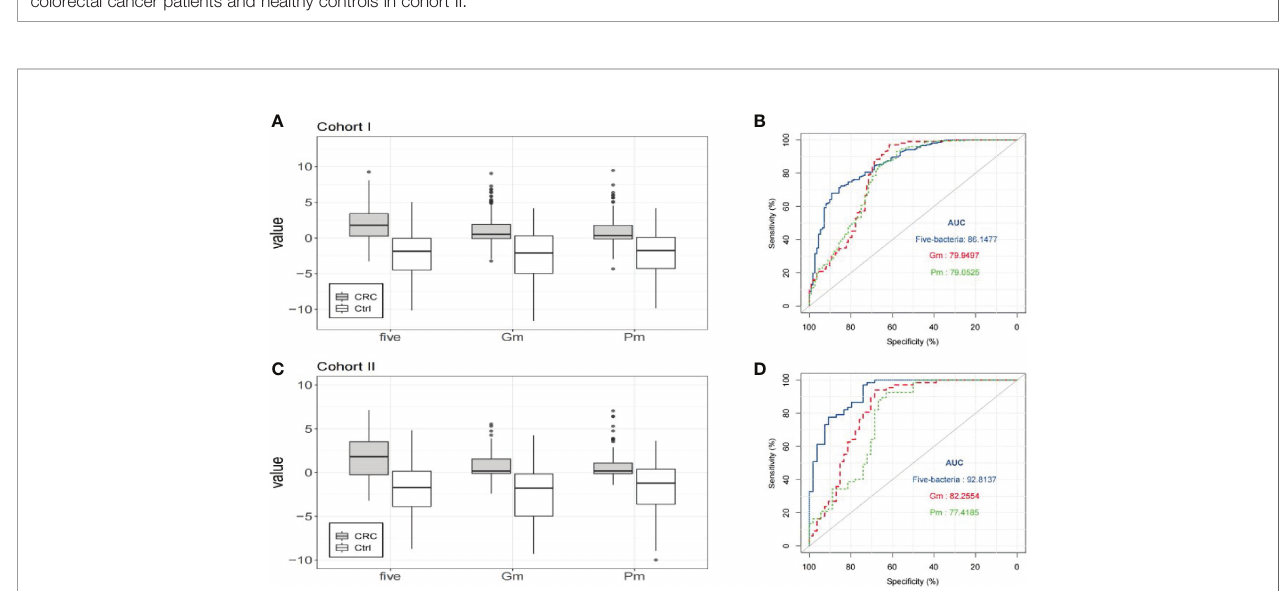
FIGURE 3 | The combination of fi ve markers can improve the diagnostic ability of colorectal cancer (CRC). (A) Compared with the healthy control group of cohort I, the relative stool abundance of Gm , Pm , and fi ve bacteria ( Gm , Pm , Pc , Ps , Cs ) in colorectal cancer patients. (B) The ROC curve of the fi ve selected candidate bacterial markers in cohort I, including the simple linear combination of Prevotella copri ( Pc ), Gemella morbillorum ( Gm ), Parvimonas micra ( Pm ), Cetobacterium somerae ( Cs ), and Pasteurella stomatis ( Ps ). (C) Compared with the healthy control group of cohort II, the relative stool abundance of Gm , Pm , and fi ve bacteria ( Gm , Pm , Pc , Ps , Cs ) in colorectal cancer patients. (D) The ROC curve of the fi ve selected candidate bacterial markers in cohort II, including the simple linear combination of Prevotella copri ( Pc ), Gemella morbillorum ( Gm ), Parvi monasmicra ( Pm ), Cetobacterium somerae ( Cs ), and Pasteurella stomatis ( Ps